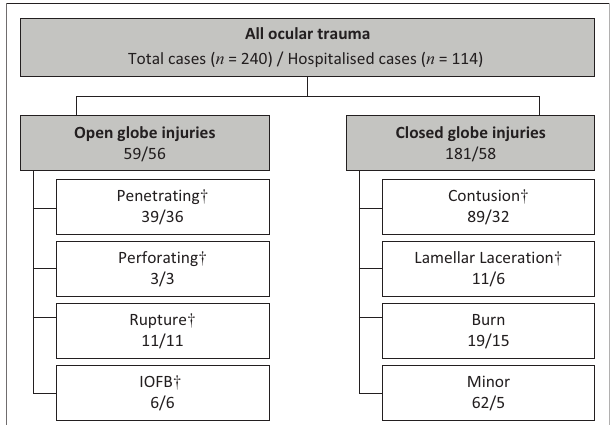
TABLE 2: Comparison of open versus closed ocular trauma ( n = 240).